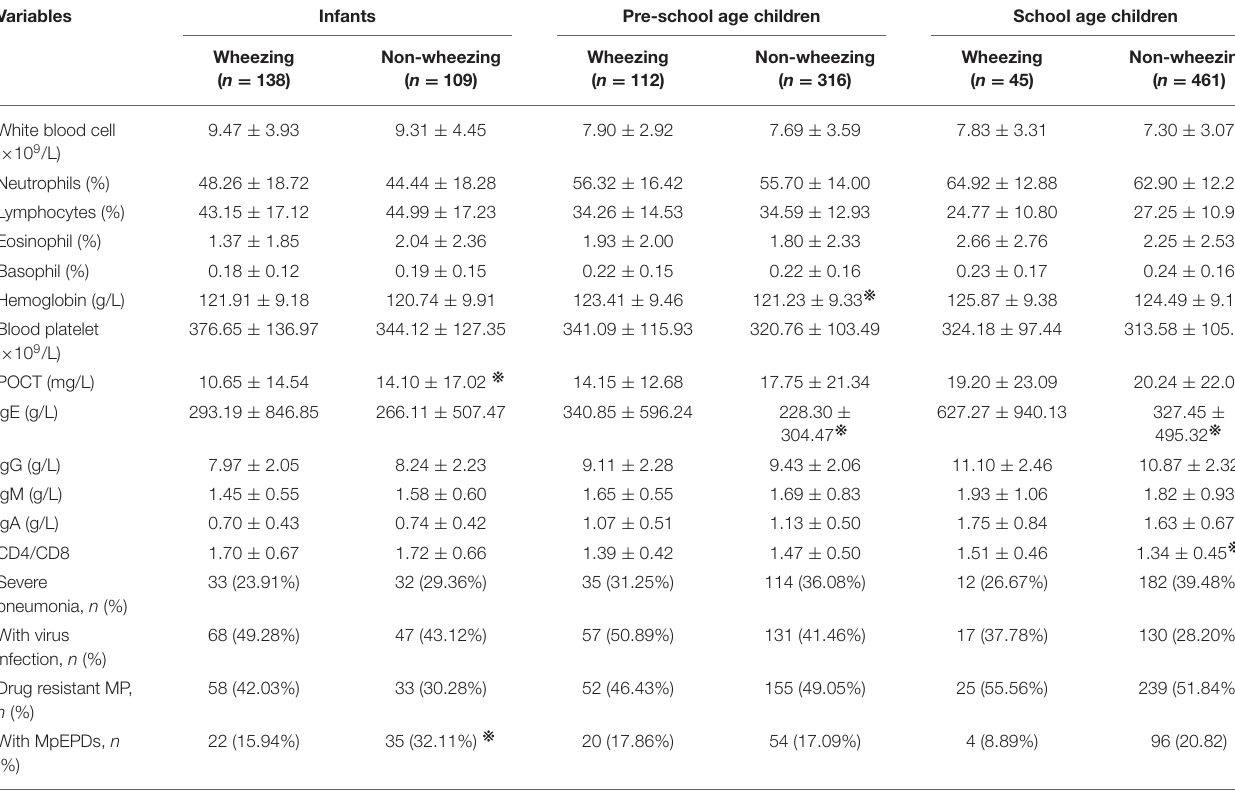
TABLE 2 | Laboratory findings of MP-infected patients with and without wheezing. Variables